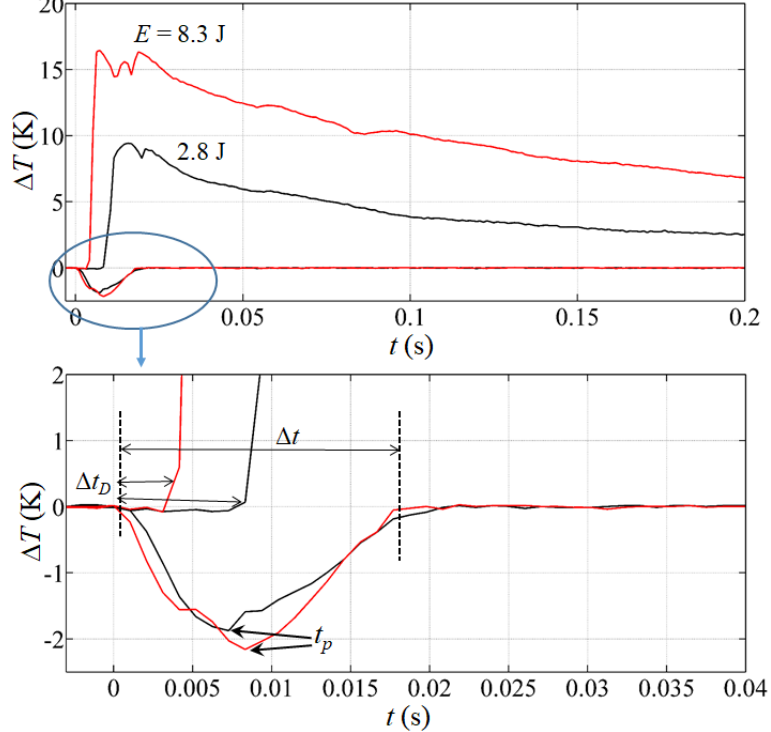
Figure 4. ∆ T -time plots; a comparison between ∆ T Max and ∆ T Min distributions for E = 2.4 and 8.3 J on the top; a magnification to show ∆ t , ∆ t D and t p parameters on the bottom. ∆ T Max and ∆ T Min are searched for in a region wide enough to include either the zone with cracks in progress or the zone which continues to bend leading to the ∆ T Min peak before the end of impact.